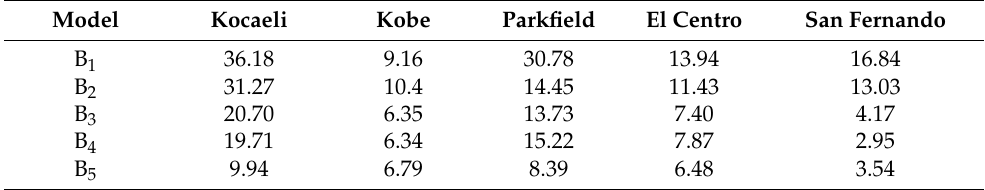
Table 3. Maximum lateral displacement for different models under various ground motions (cm).